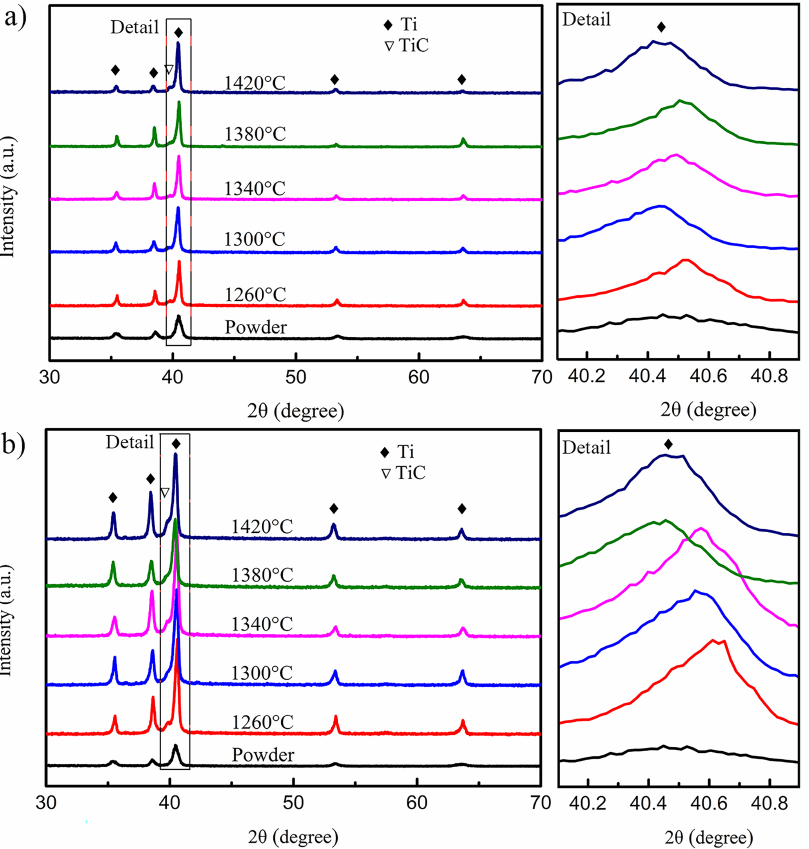
Figure 12. The XRD patterns of original powder and the samples sintered at di ff erent temperatures: ( a ) the pure powder, ( b ) the mixed powder.